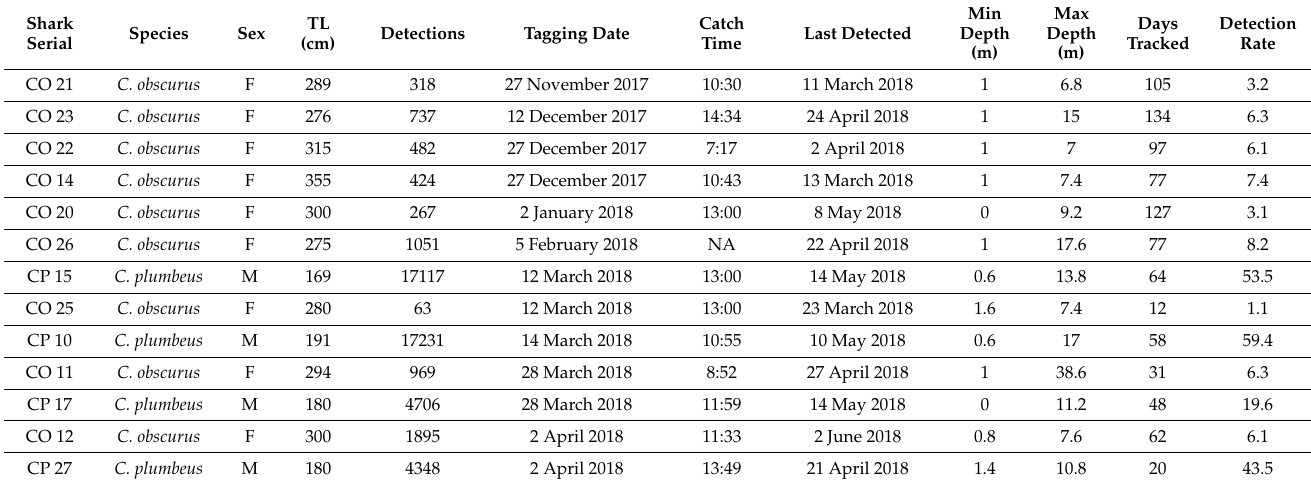
Table 1. Summary of biological and detection data for sharks tagged with depth sensors at the warm effluent of Orot Rabin (OR) power station, ordered by the tagging date. Detection rate stands for the number of detections per hour per receiver.